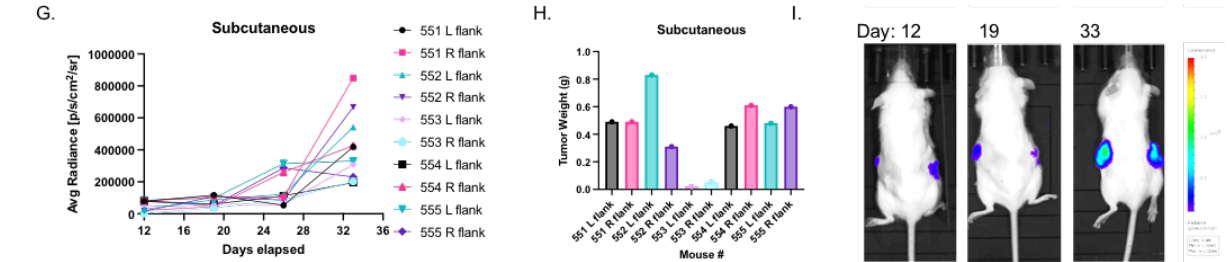
Figure 1. In vivo growth characteristics of luciferase labeled STOSE murine ovarian cancer cells: ( A ) Syngeneic ovarian intrabursal tumor growth of STOSE.M1 luc cells (1 × 10 4 –1 × 10 5 ) in female